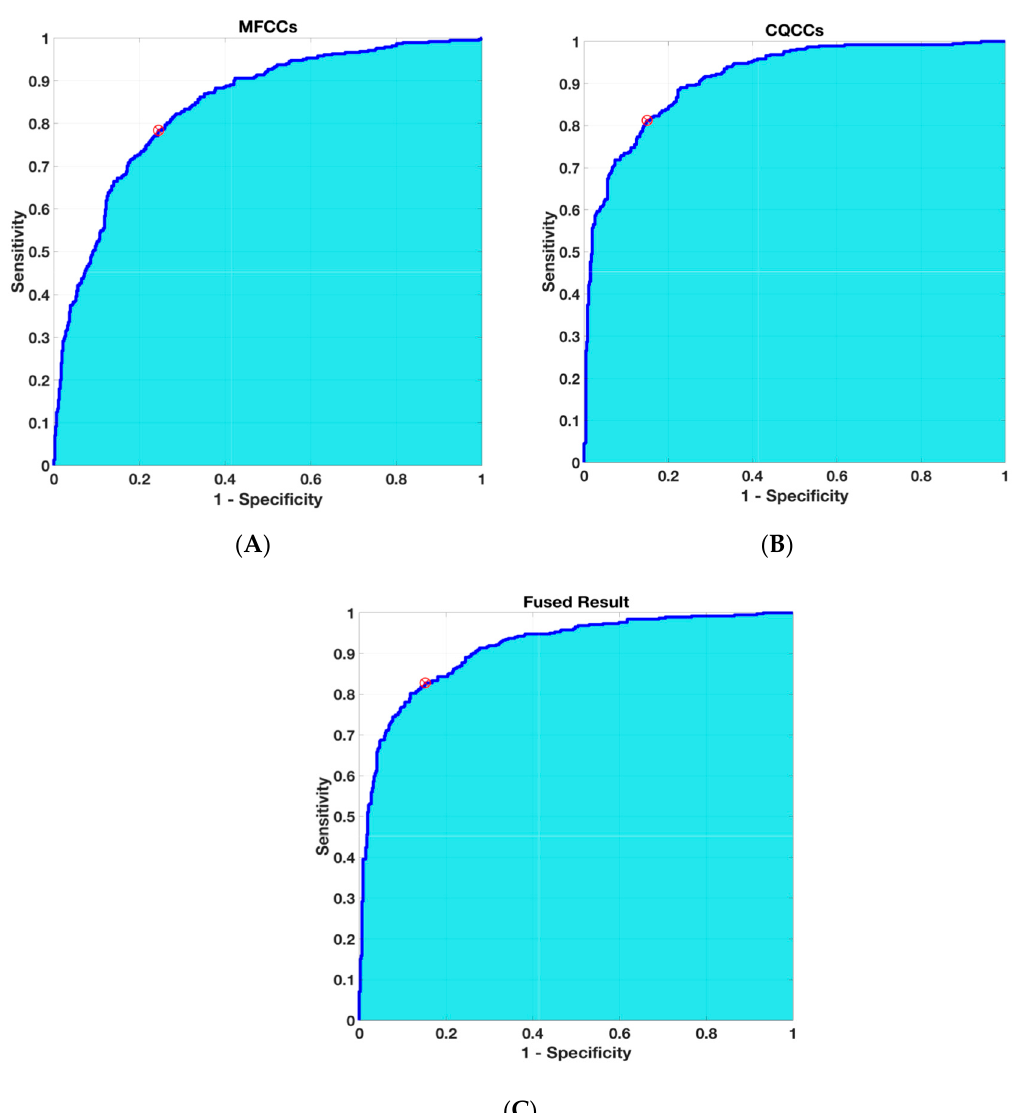
Figure 4. Receiver Operator Characteristic (ROC) curves of the classification model built with ( A ) MFCCs, ( B ) CQCCs, and ( C ) Fused features (area under ROC, shaded).